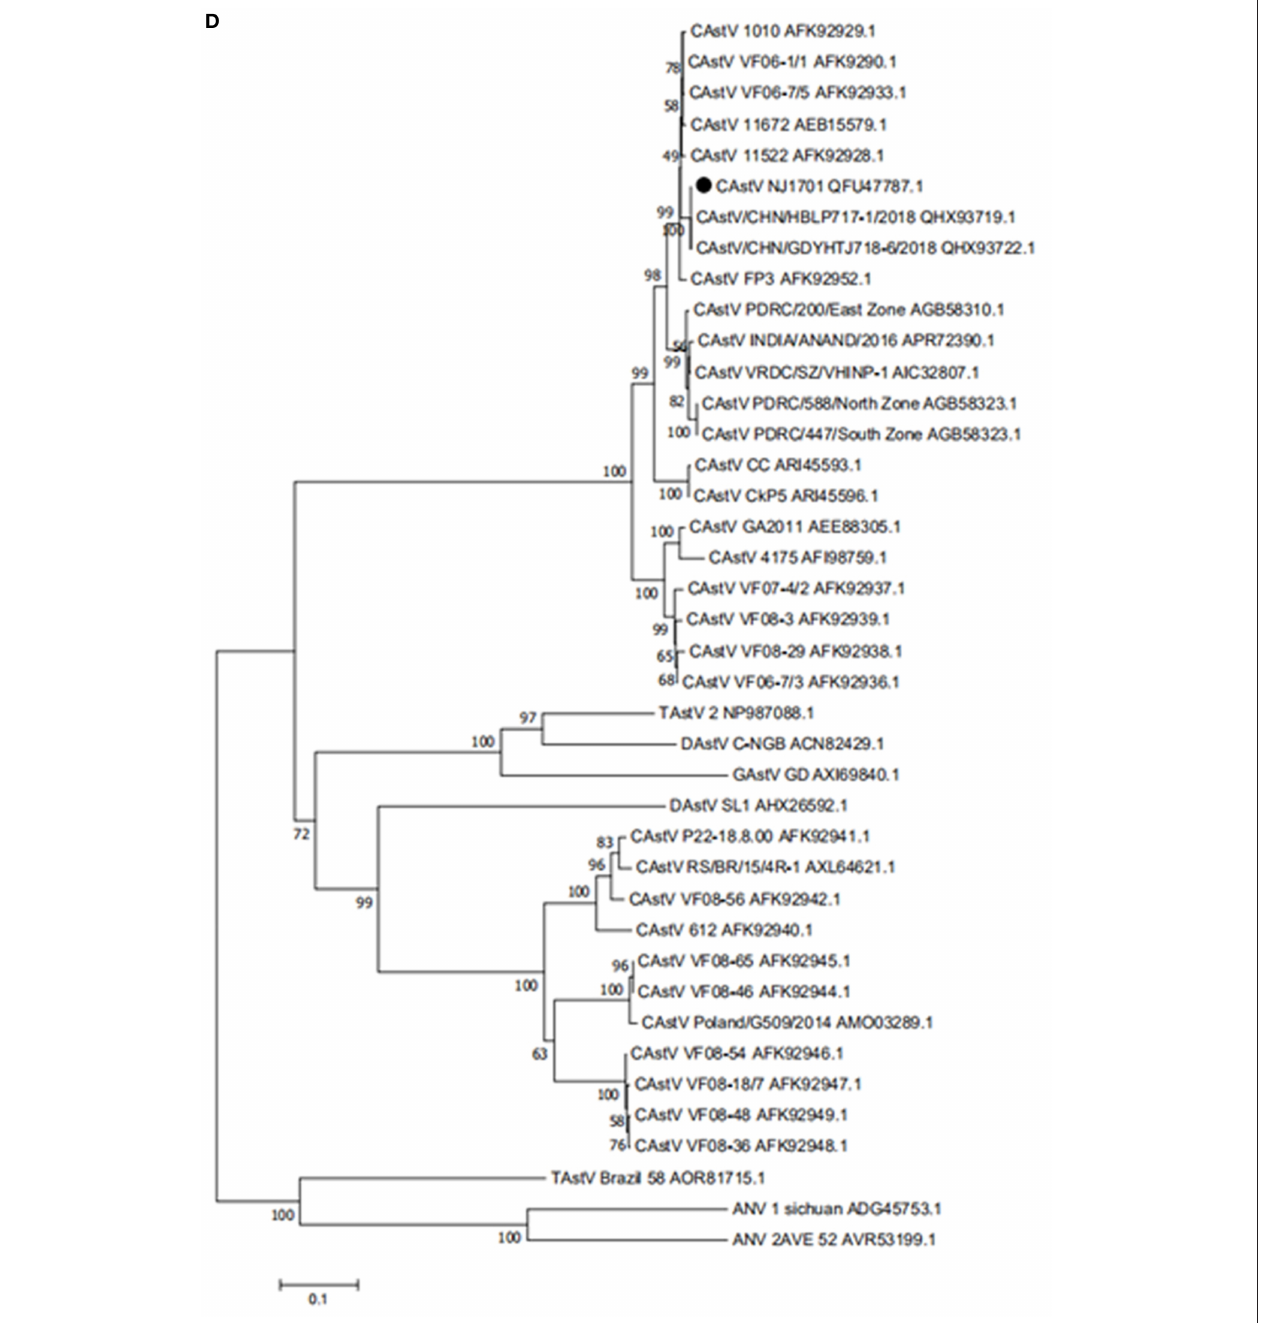
FIGURE 3 | Phylogenetic relationships between CAstVs in this study and other avian astroviruses. The phylogenetic analysis of chicken astrovirus isolate NJ1701 was based on the nucleotide sequences of the complete genome (A) and on amino acid sequences of the complete ORF1a (B) , ORF1b (C) , and ORF2 (D) regions using neighbor-joining method with 1,000